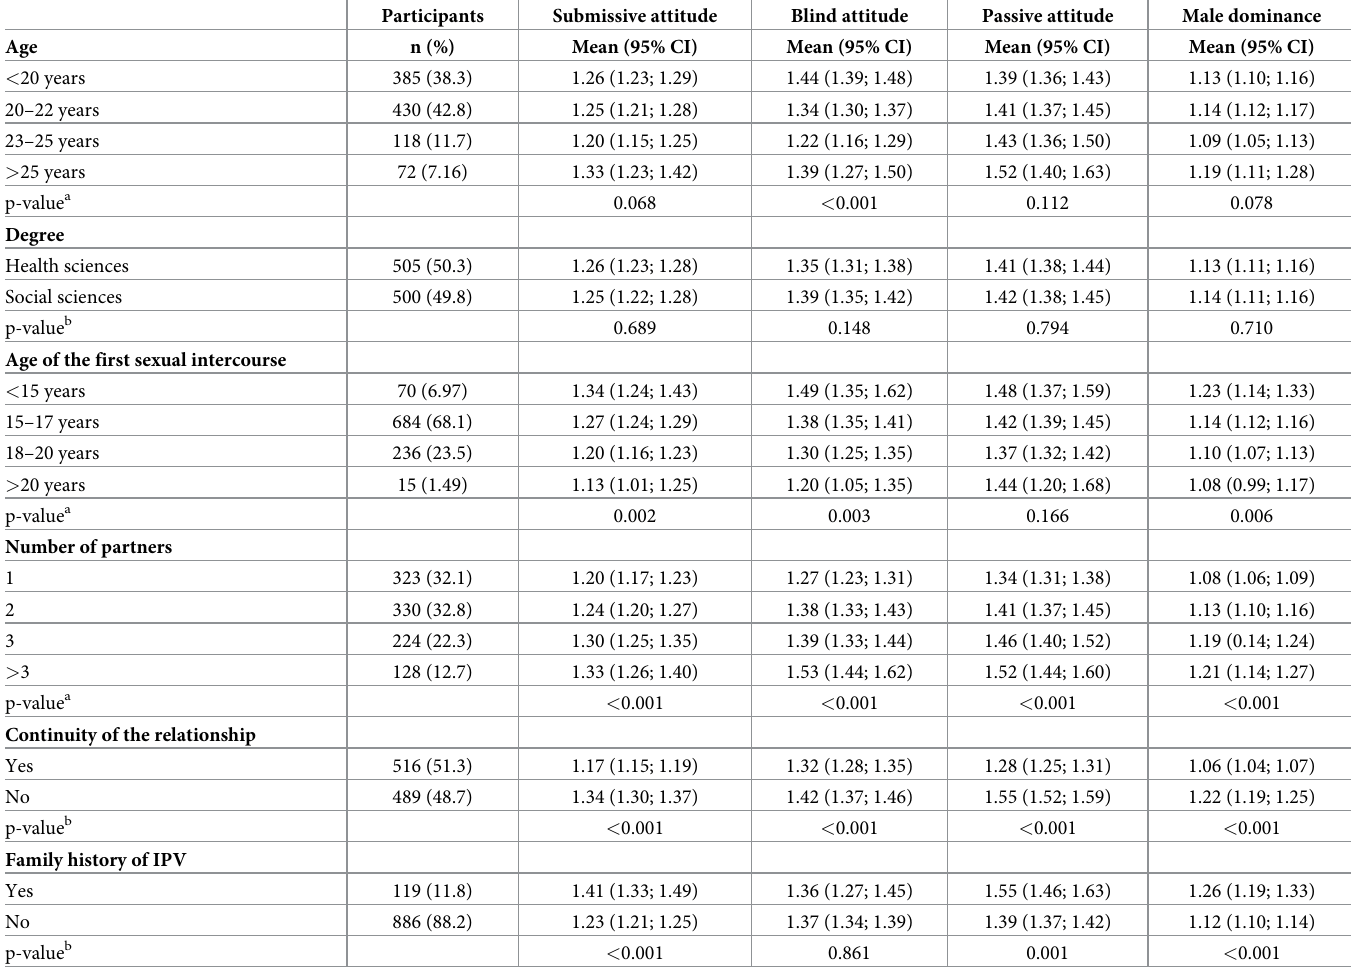
Table 1. Sampling distribution and mean scores of GRs according to the characteristics of participants (n =